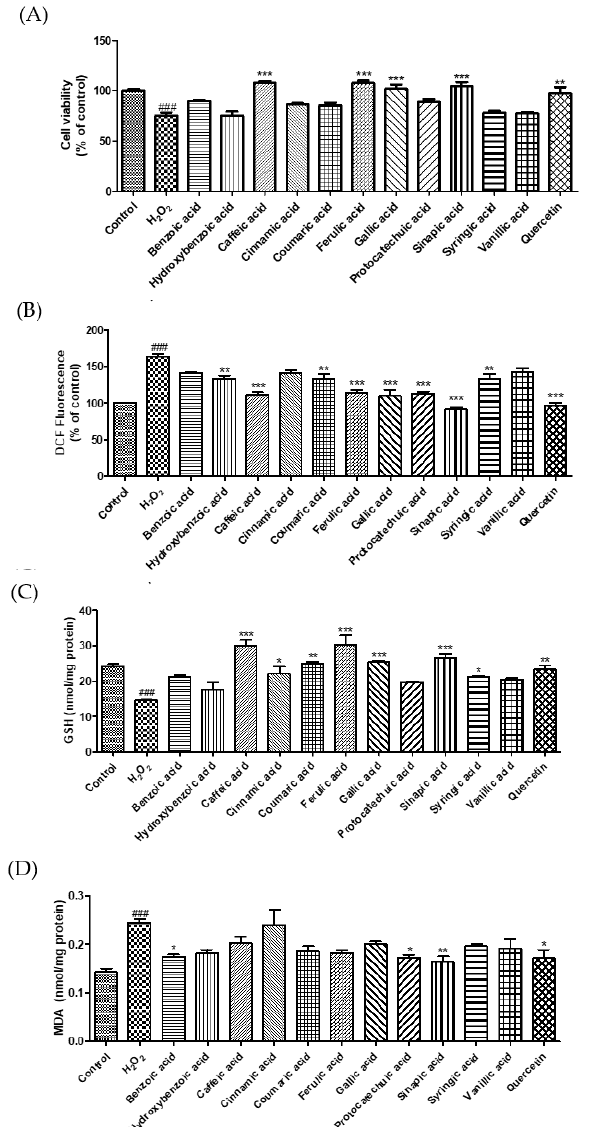
Figure 3. Effect of selected phenolic acids (50 µ M) on cell viability ( A ), the generation of reactive oxygen species ( B ), glutathione ( C ), and malondialdehyde ( D ) against hydrogen peroxide (600 µ M) in EA.hy 926 cells. Quercetin (25 µ M) was used as positive control. Each value was expressed as the mean ± standard error ( n = 3). Statistical significance was analyzed using the Tukey test. ### p < 0.001 versus nontreated cells. * p < 0.05, ** p < 0.01, and *** p < 0.001 versus hydrogen-peroxide-treated cells. 3.3. Effects of Sinapic Acid on the Expression of Phase II Enzymes and the Activation of Nrf2